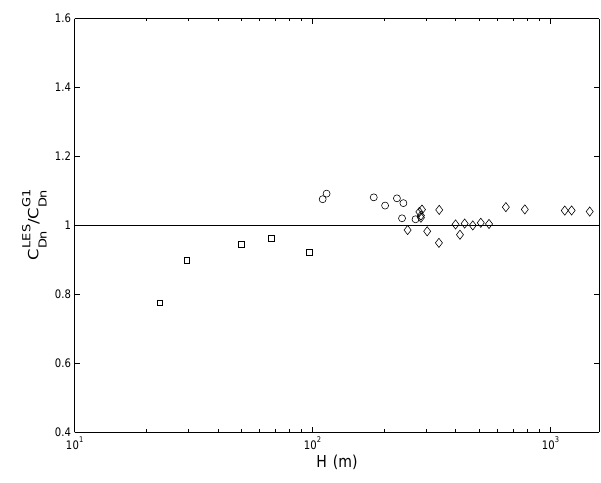
/C G 1 on the PBL depth H . C G 1 Dn Dn